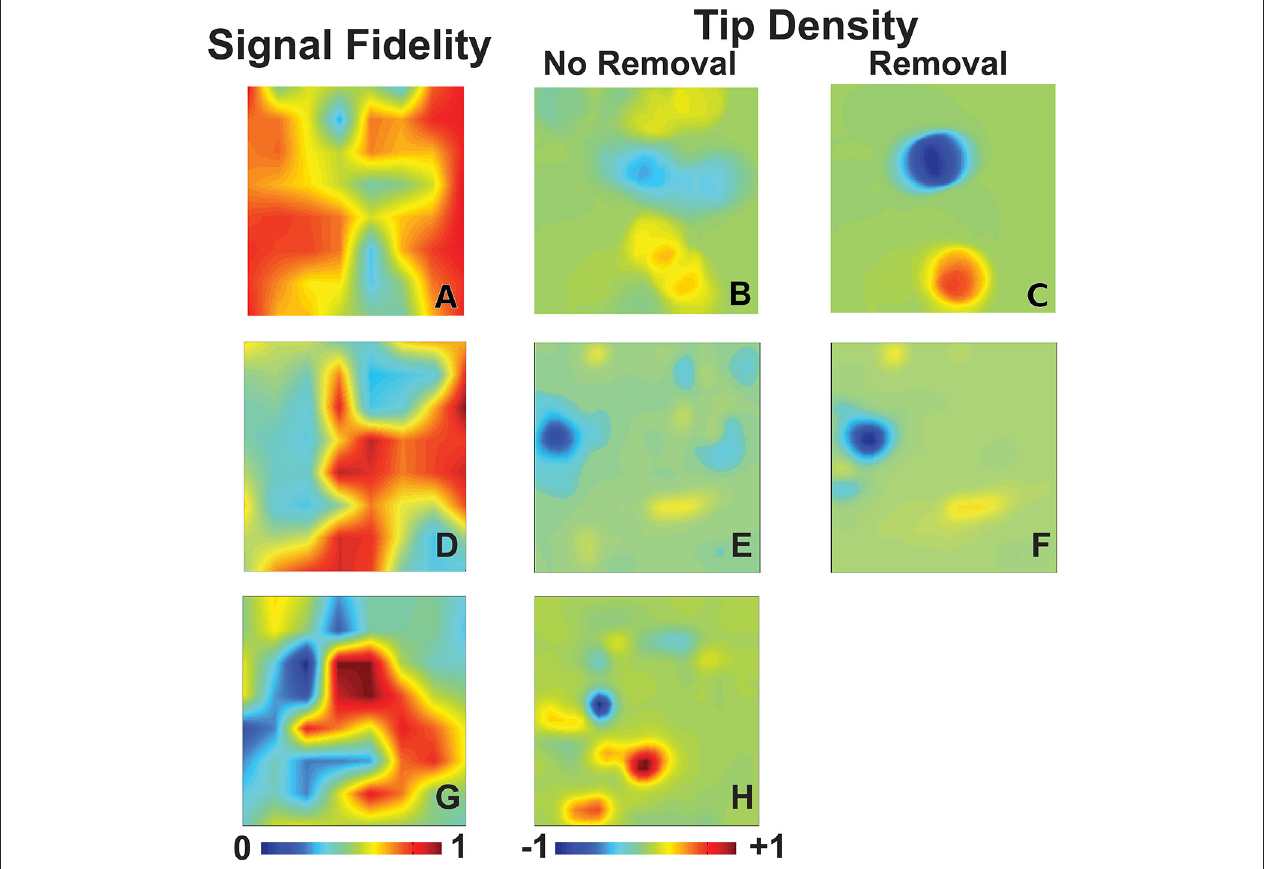
FIGURE 2 | Signal fidelity in patients during AF. (A–C) Signal fidelity map (A) for an episode of human AF corresponding to the electrograms shown in Figure 1 (67 years-old female patient). The corresponding tip density map, with clockwise rotations in red and counter-clockwise rotations in blue, and tip density map after k-means removal, and interpolation over, electrogram recordings with low fidelity are shown in (B) and (C) , respectively. High values of tip density show concordance with domains of low fidelity. The magnitude of maximum tip density around the termination site (blue peak) was 0.43. The magnitude of maximum tip density around the termination site increases significantly to 0.94. (D–F) Signal fidelity map (D), tip density map (E) , and tip density map after removal of low fidelity electrodes (F) corresponding to an episode of human AF of a 66 years old male patient. (G–H) Signal fidelity map for an episode of human AF of a 49 years old male patient (G) and the corresponding tip density map (H)